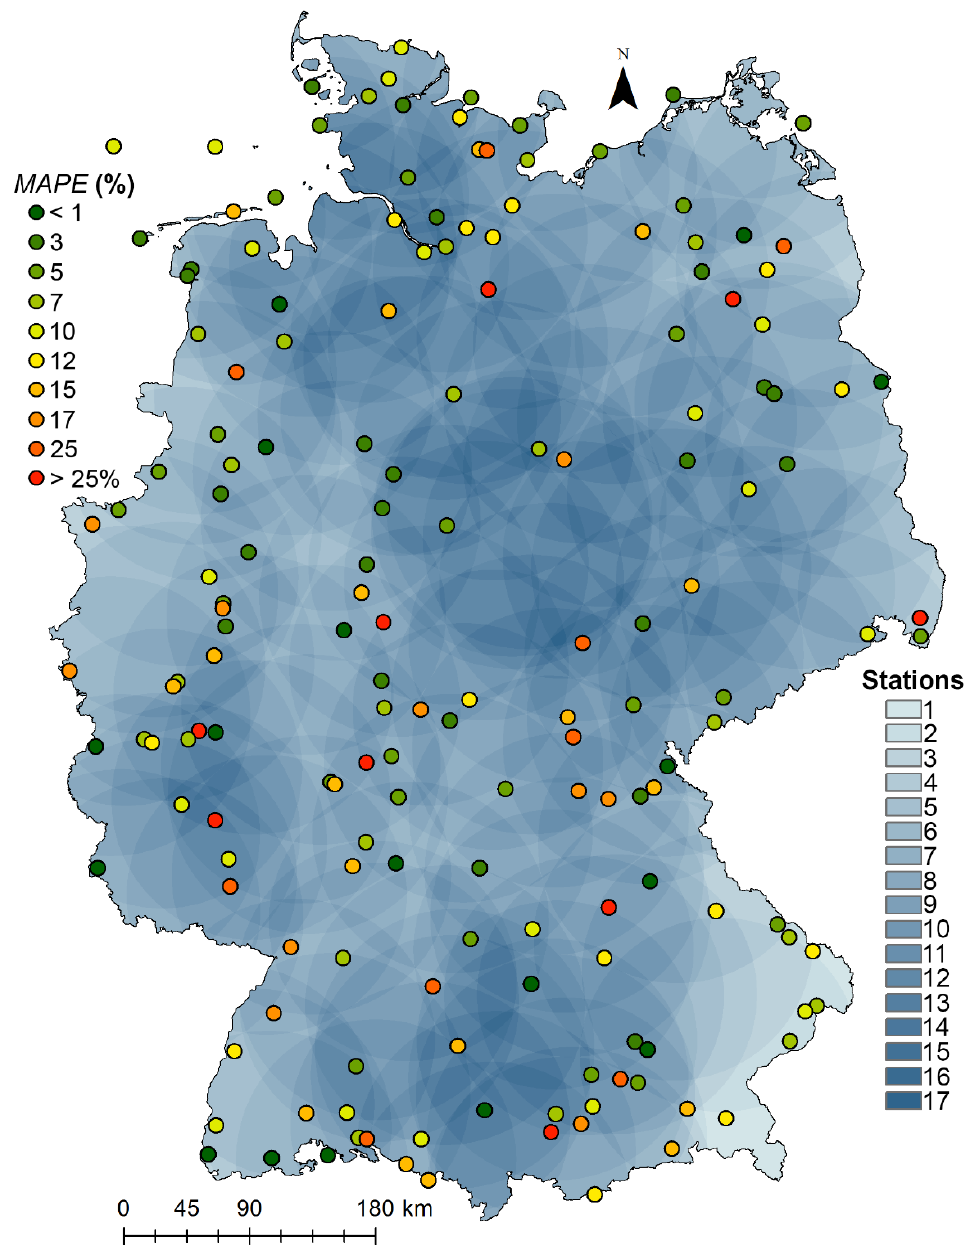
Figure 10. Number of parameterization dataset (DS1) stations in a 100 km radius and mean absolute percentage error ( MAPE ) related to DS2 measurement stations.